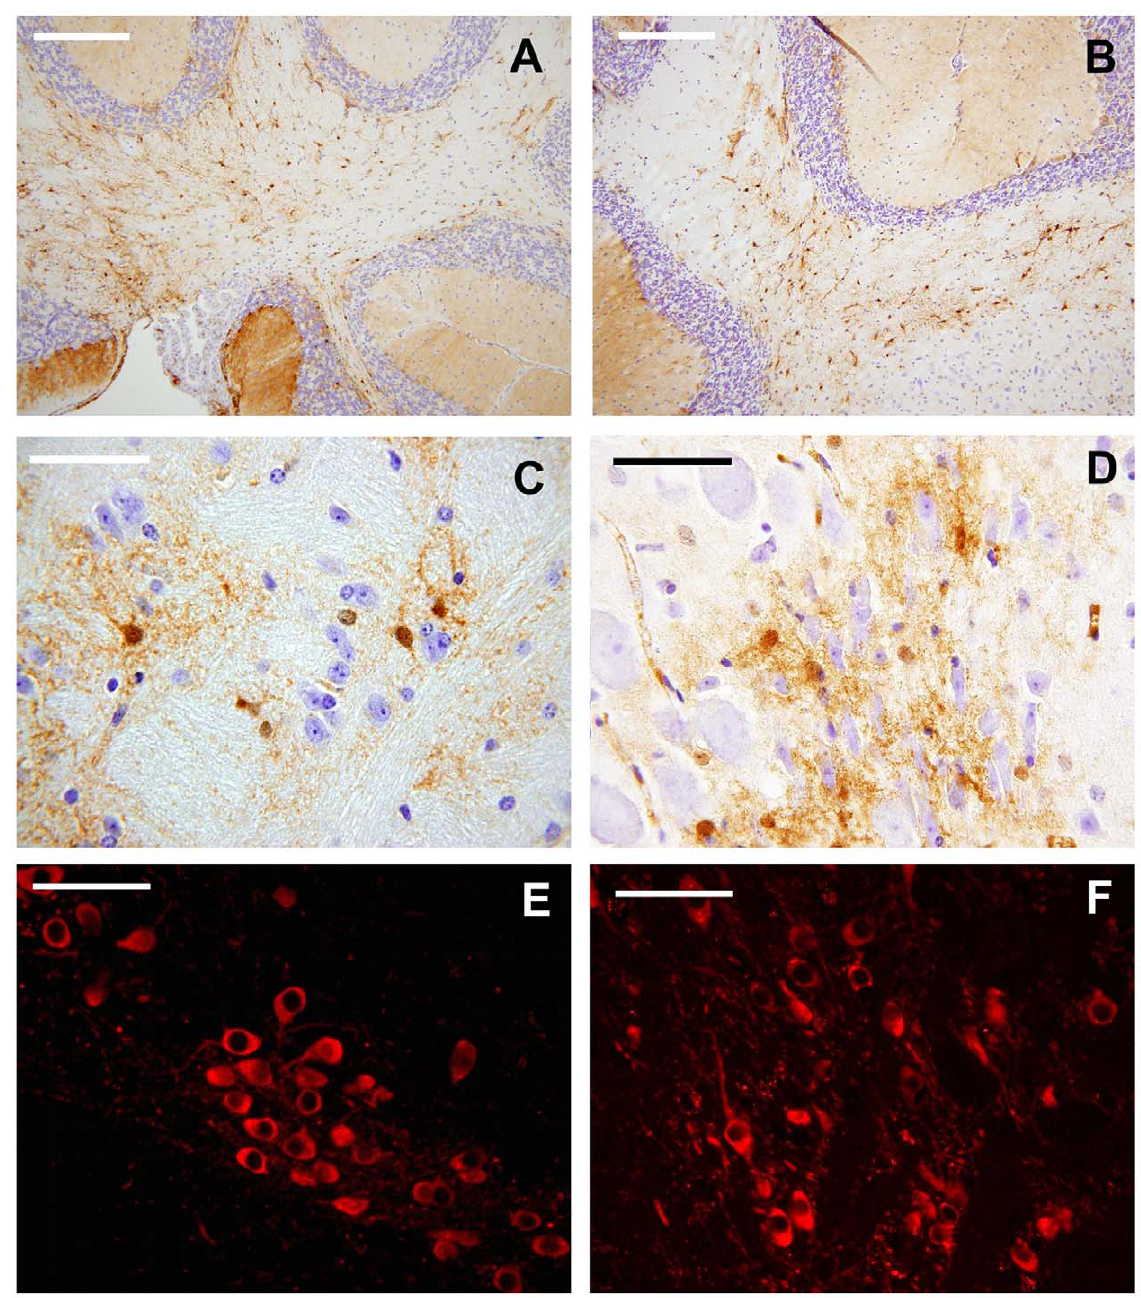
Figure 7. Representation of Immunohistochemical results. The images are relative to sagittal sections of the brain. Left column (A, C, E): CuD mice. Right column (B, D, F): control group. (A, B) MT I-II immunohistochemistry, cerebellum; scale bar=200 m m; C, ventral tegmental area of the mesencephalon, scale bar=50 m m; (D) locus cœruleus , scale bar=50 m m; (E, F) TH-immunohistochemistry, (E) substantia nigra , scale bar=50 m m.